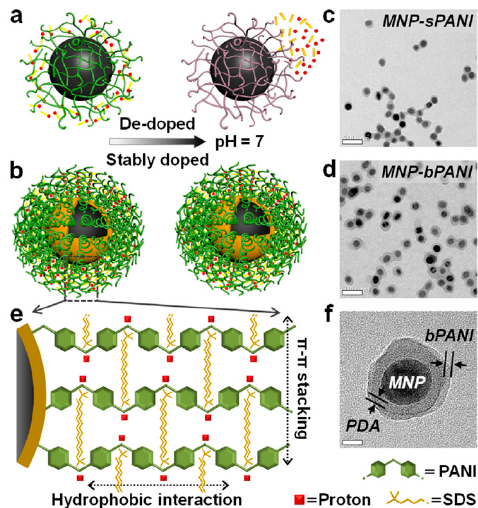
Figure 5. Design of stably doped PANI nanoshells. ( a ) Schematic illustrating conventional loosely packed PANI (spaghetti-like). The PANI layer loses its signature properties owing to dopant leaching at neutral pH; ( b ) Densely packed brush PANI with excellent doping stability; ( c , d ) Transmission electron microscope (TEM) showing the successful coating of PANI nanoshells on MNPs. Scale bar, 100 nm; ( e ) Diagram illustrating a high-density PANI brush polymerized on an intermediate PDA layer. Protons (red dots) and SDS (gold wires) are stably trapped owing to the strong interactions between the conjugate polymer chains and dopants; ( f ) TEM showing PDA-PANI dual shell layers on a MNP. Scale bar, 20 nm. Reprinted with permission from [42]. Copyright 2015, American Chemical